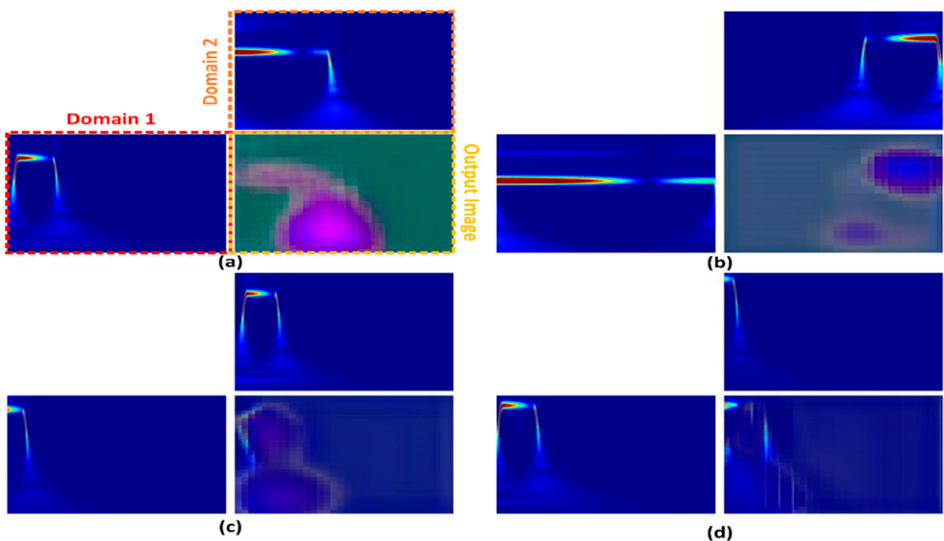
Figure 20. Reference images generated during the training process with domain knowledge transfer ( a ) speed (40 and 20)% at 10,000 iterations, ( b ) (10 and 30)% at 20,000 iterations, ( c ) (100 and 60)% at 30,000 iterations, and ( d ) (80 and 100)% at 40,000